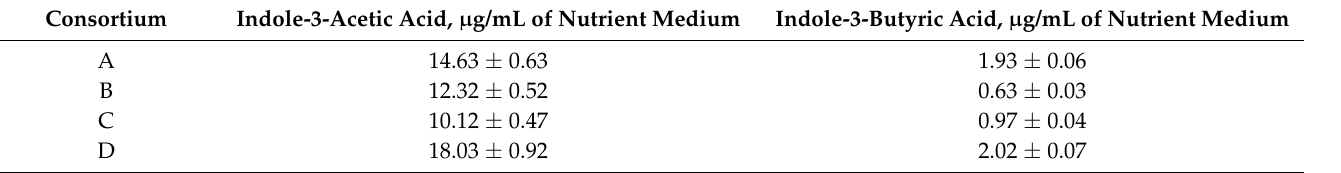
Table 9. Synthesis of phytohormones by consortia.